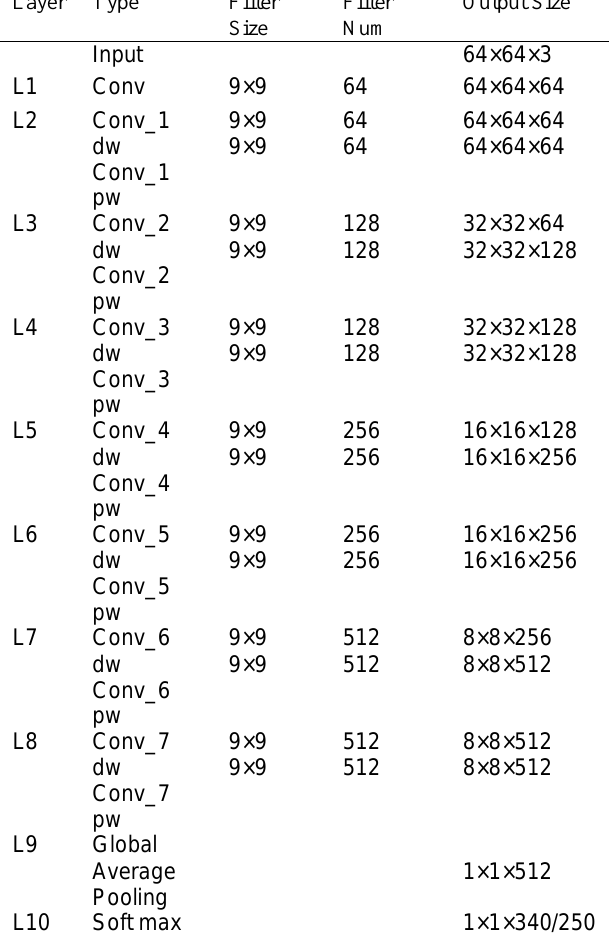
Table 1. LW-Sketch-Net